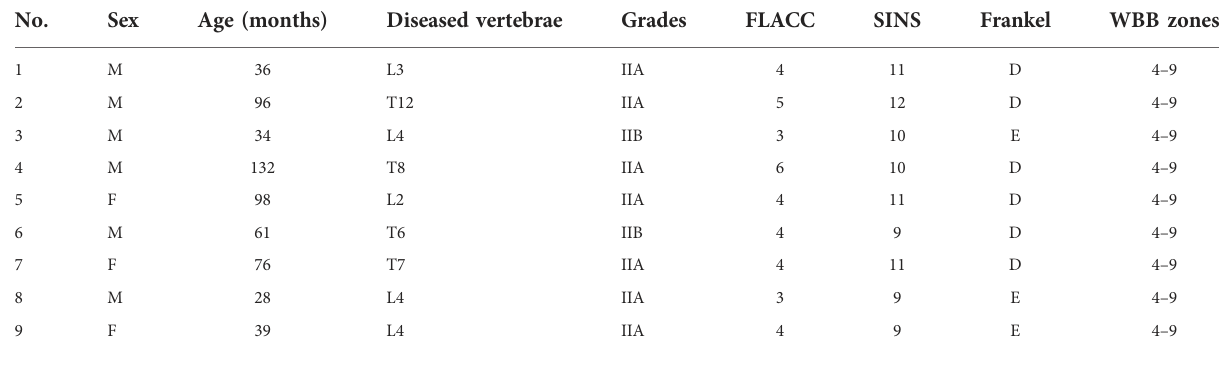
TABLE 1 Patients ’ characteristics of BKP